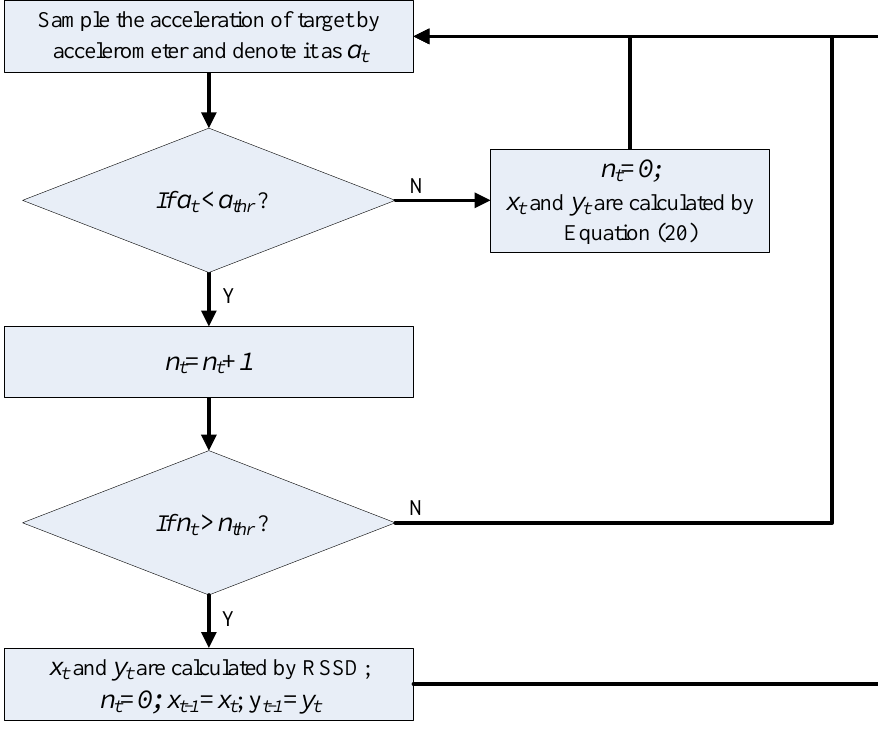
Figure 9. Target localization procedure.